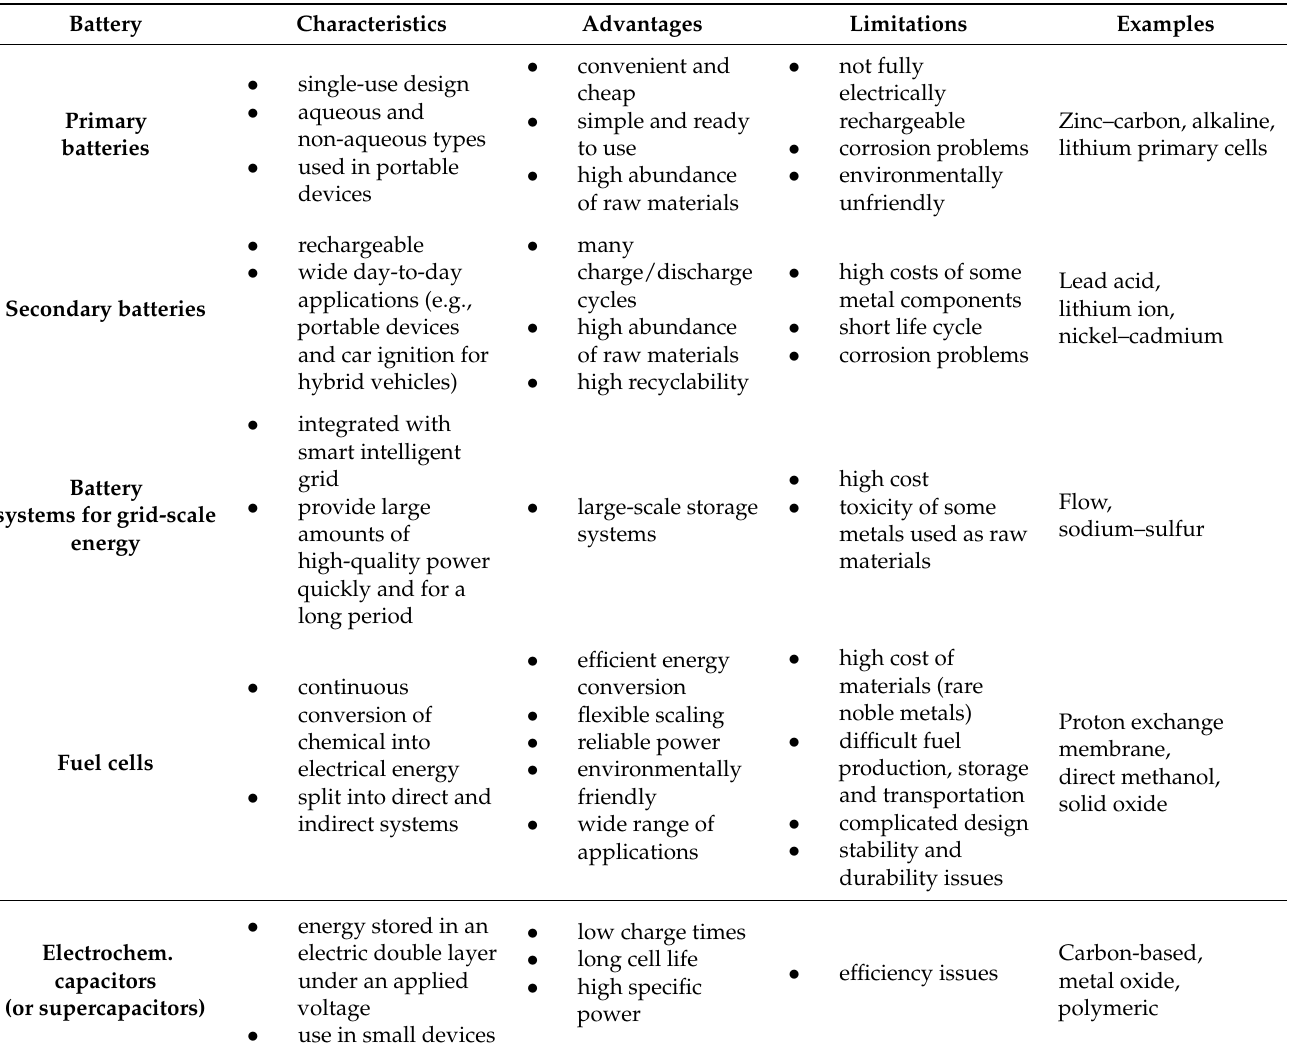
Table 7. Descriptions, advantages, limitations and examples for all types of electrochemical energy storage